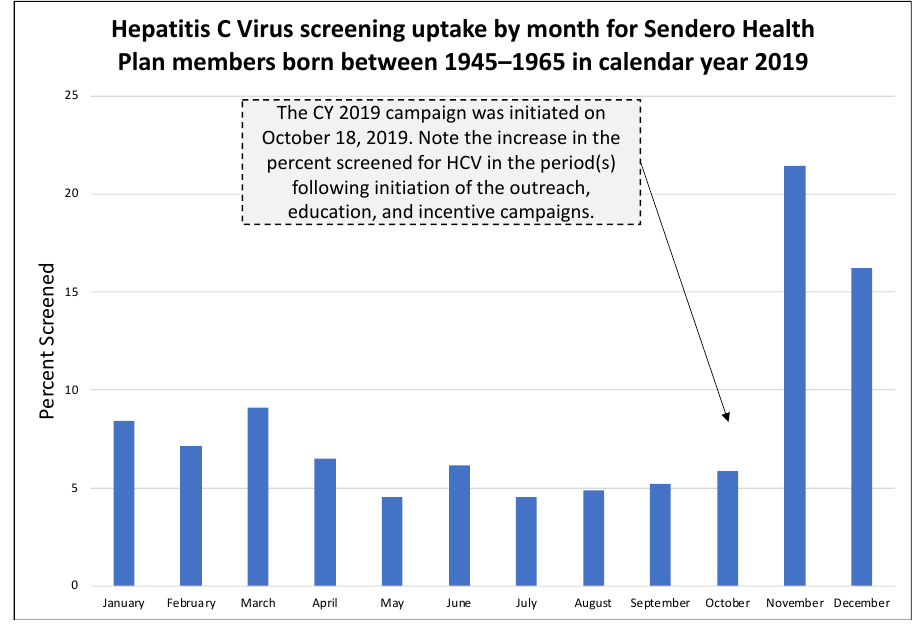
Figure 1. Hepatitis C Virus uptake by month for Sendero members born between 1945 – 1965 in calendar year 2019.